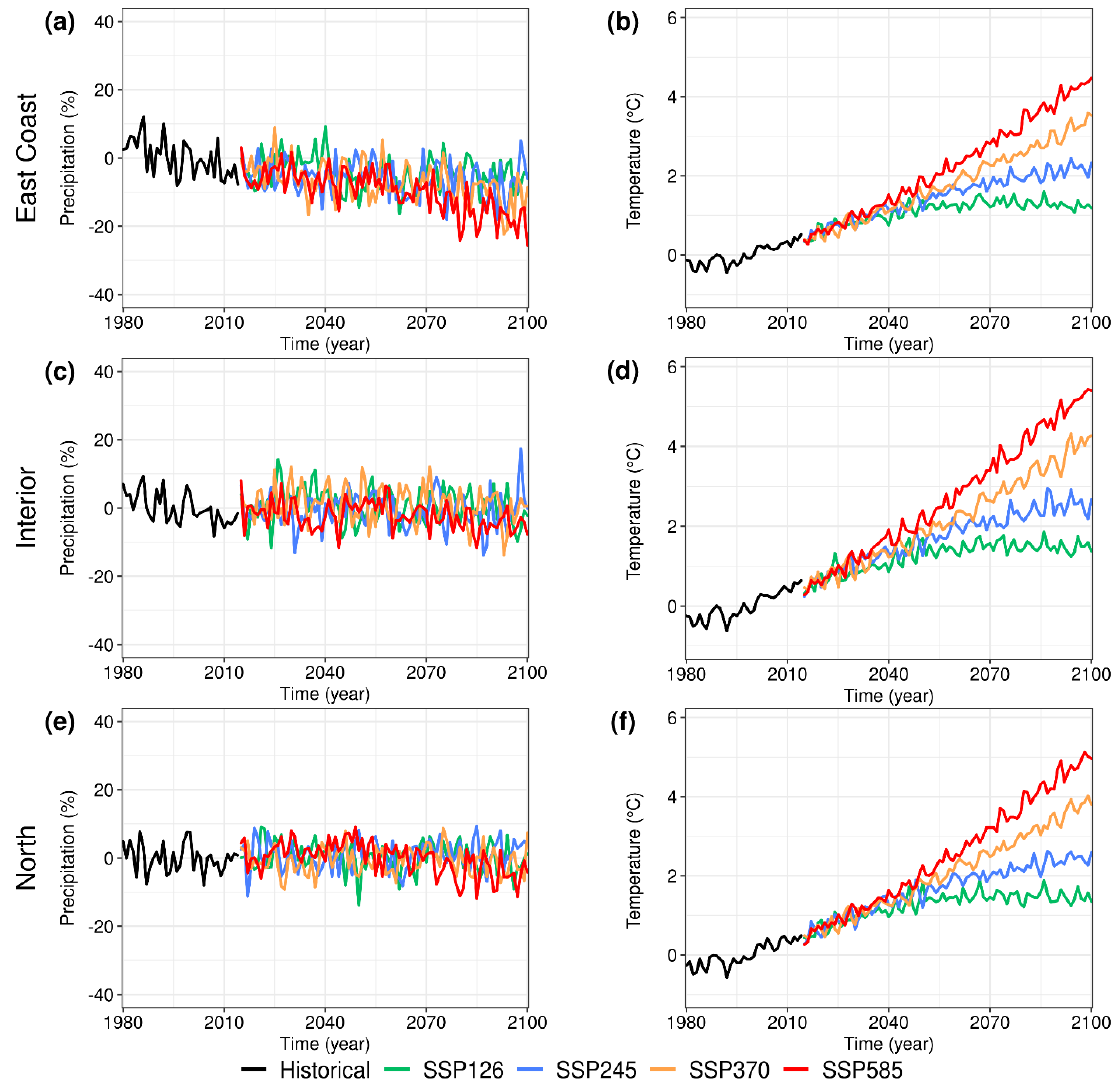
Figure 8. Projections of total annual precipitation anomalies (%) and air temperature near the surface (°C) on NEB relative to the reference period (1980–2014): ( a , b ) East Coast, ( c , d ) Interior, and ( e , f ) North. The colored lines correspond to the average of the 15 models (ensemble) of CMIP6 for the SSP1-2.6, SSP2-4.5, SSP3-7.0, and SSP5-8.5 scenarios.